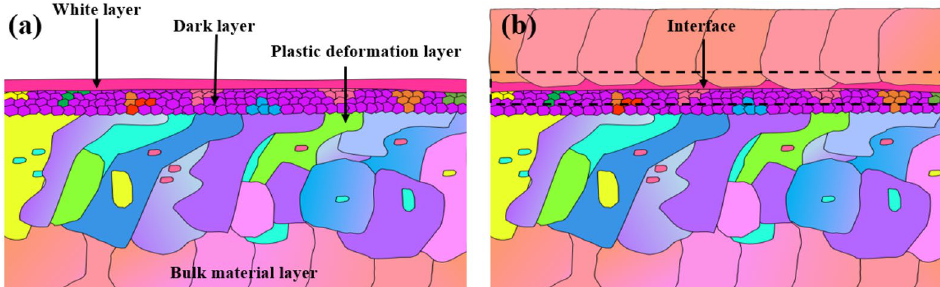
Figure 17 Schematics of a machined surface and b interface of SLMed/HSMed